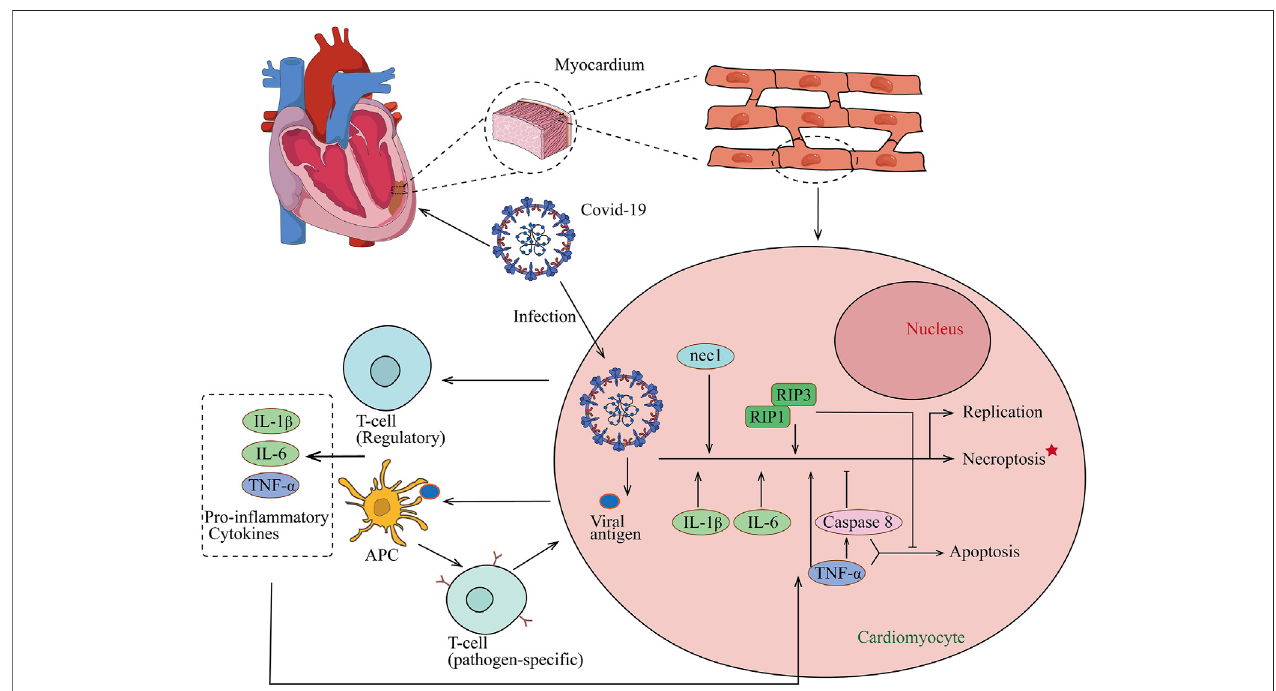
FIGURE 2 | Proposed model for COVID-19 association with myocarditis. After COVID-19 infection, naive T lymphocytes can be primed for viral antigens via antigen-presenting cells, and proin fl ammatory cytokines of IL-1B, IL-6, and TNF- α which are involved in necroptosis are released into the circulation. The release of cytokines results in a positive feedback loop of immune activation and myocardial damage and also helps the development of